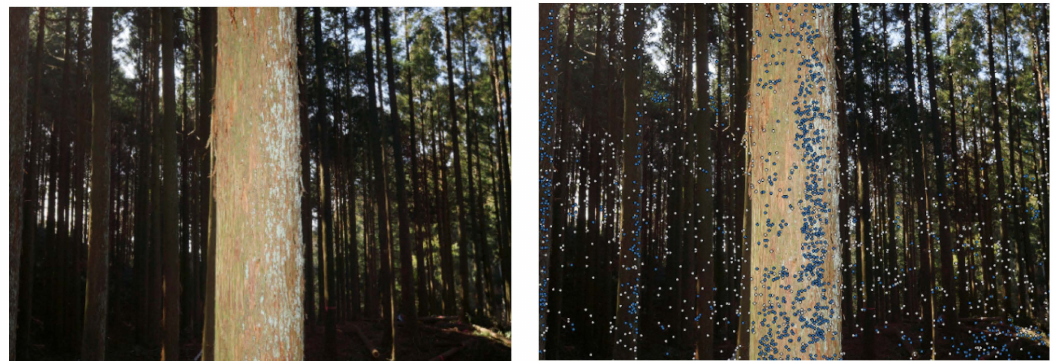
Figure 4. Example of typical surface texture of Cryptomeria japonica and the points automatically detected by Agisoft Photoscan ©